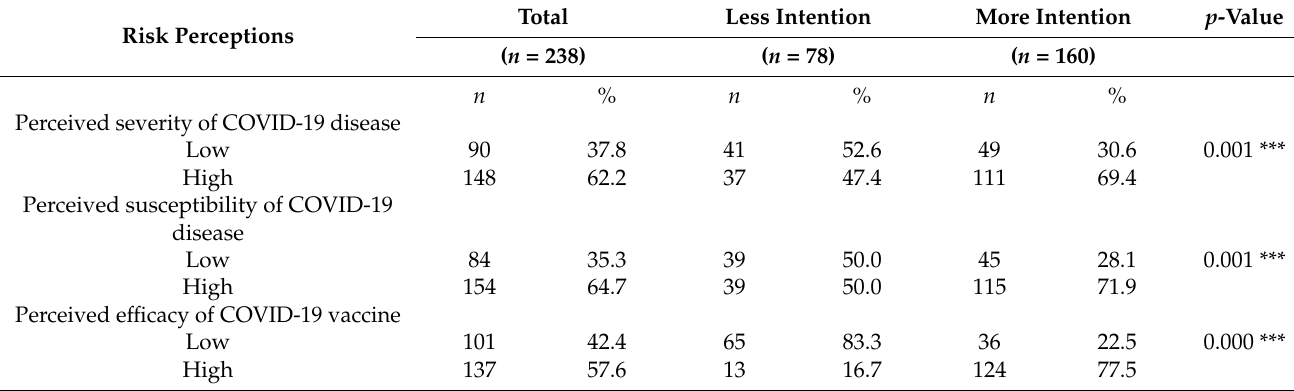
Table 3. Comparison of risk perception and perceived effectiveness between groups intending to receive COVID-19